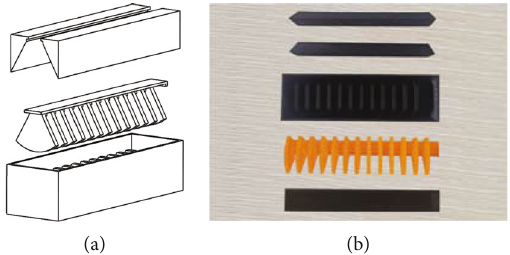
Figure 8: Mould structure. (a) Mould design of pneumatic network device. (b) Mould physical model.